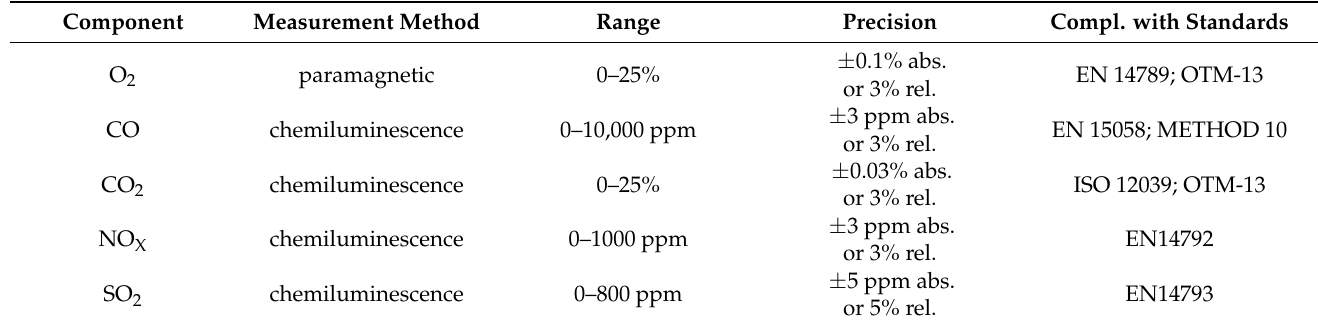
Table 4. Technical specification of the Testo 350 flue gas analyzer.